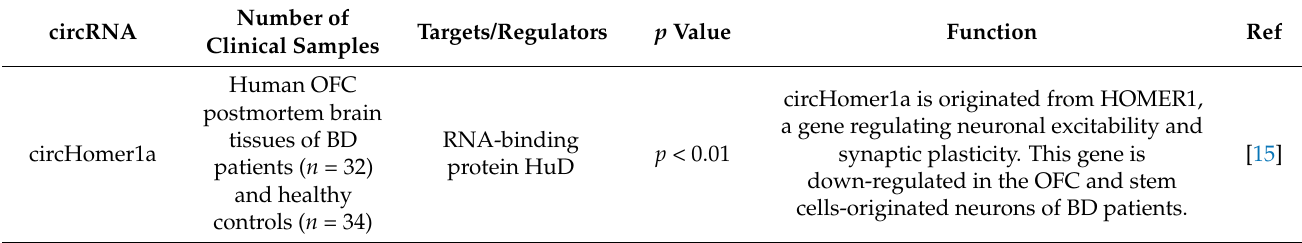
Table 2. Summary of function of down-regulated circRNAs in BD (BD: bipolar disorder, SZ: